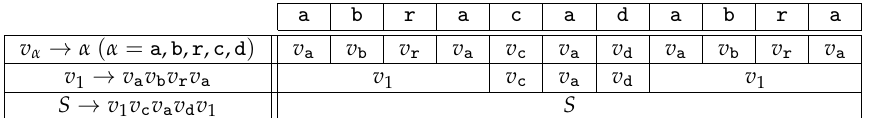
Figure 2. An example of the grammar generation process of Naïve-MR-RePair for the text abracadabra . The generated grammar is